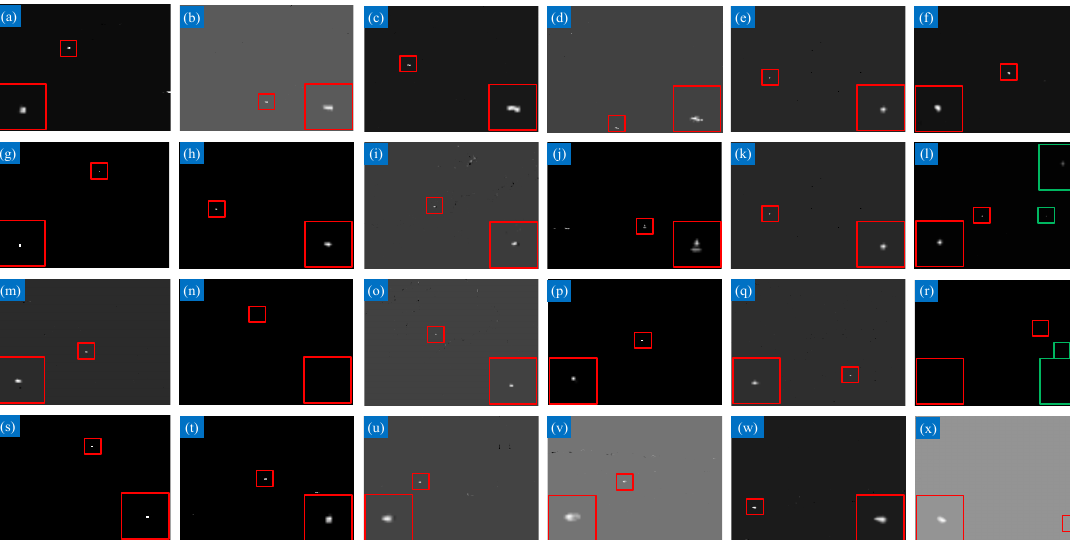
Figure A7. The separated target images of ReWIPI under 24 scenes.